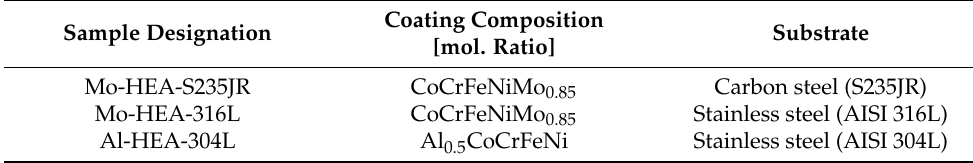
Table 1. HEA coatings compositions, and coating–substrate